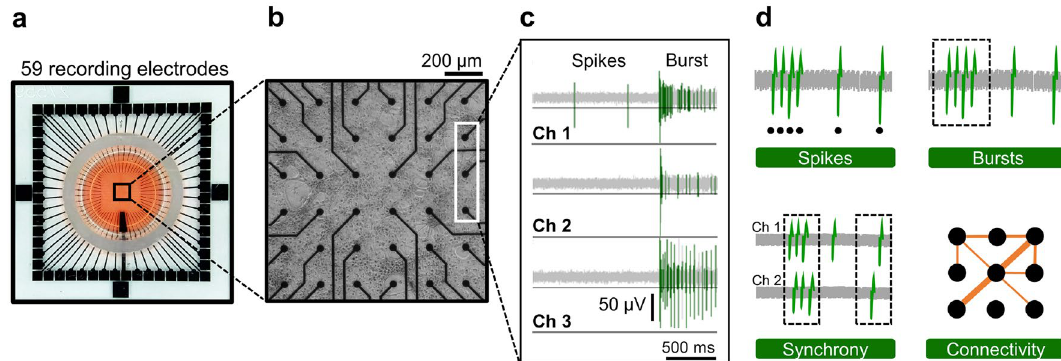
Figure 1. Electrophysiological characterization of cortical neuron cultures on MEAs. ( a ) Photograph of a 60 electrode MEA device used in the study. ( b ) Phase-contrast image of cortical neurons in culture at DIV 14. The distance between electrodes is 200 µm. Each black dot corresponds to one of the recording electrodes. ( c ) Sample traces of spontaneous electrical activity recorded by three channels. Electrical events, spikes and bursts, that crossed a threshold (horizontal black line) were recorded. ( d ) Spontaneous activity of cortical neurons was analyzed according to electrophysiological features of spikes, bursts, synchrony, and connectivity. The figure was created using MC_Rack 4.6 (https:// www. multi chann elsys tems. com/ softw are/ mc- rack) ( c ) and Microsoft PowerPoint 365 (https:// www. micro soft. com/ power point) ( d